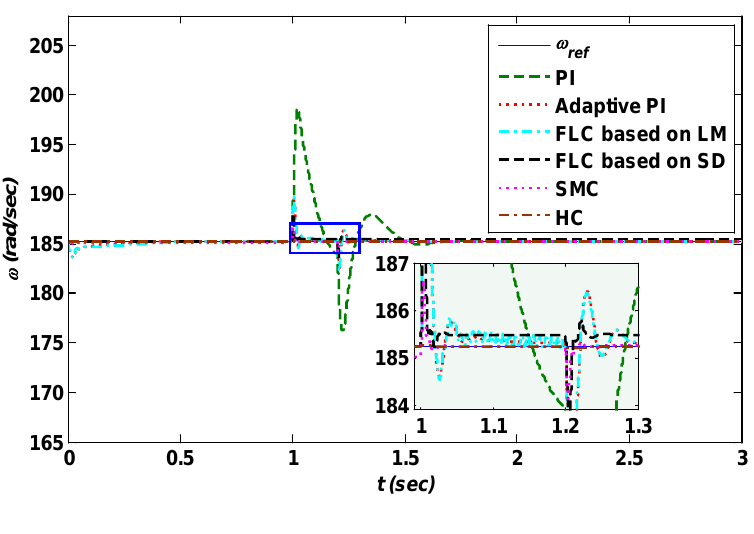
Figure 20. Overvoltage. Figure 20.